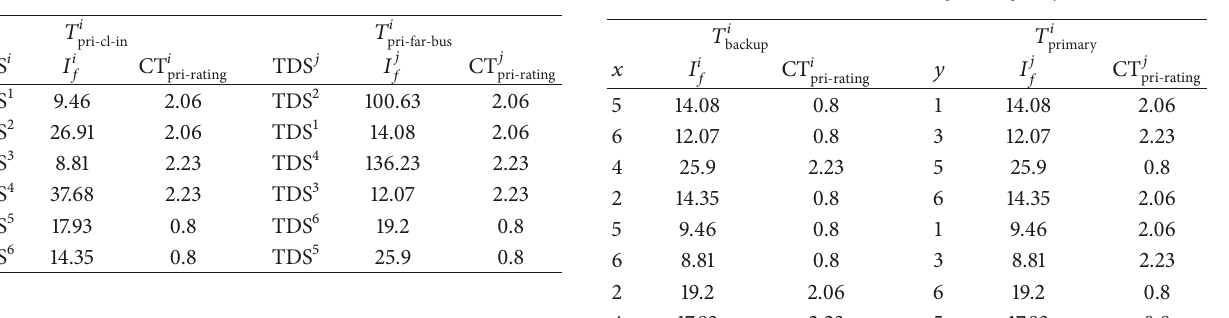
Table 6: Values of constants for objective function of 3-bus model. Table 7: Values of constants for 𝑇